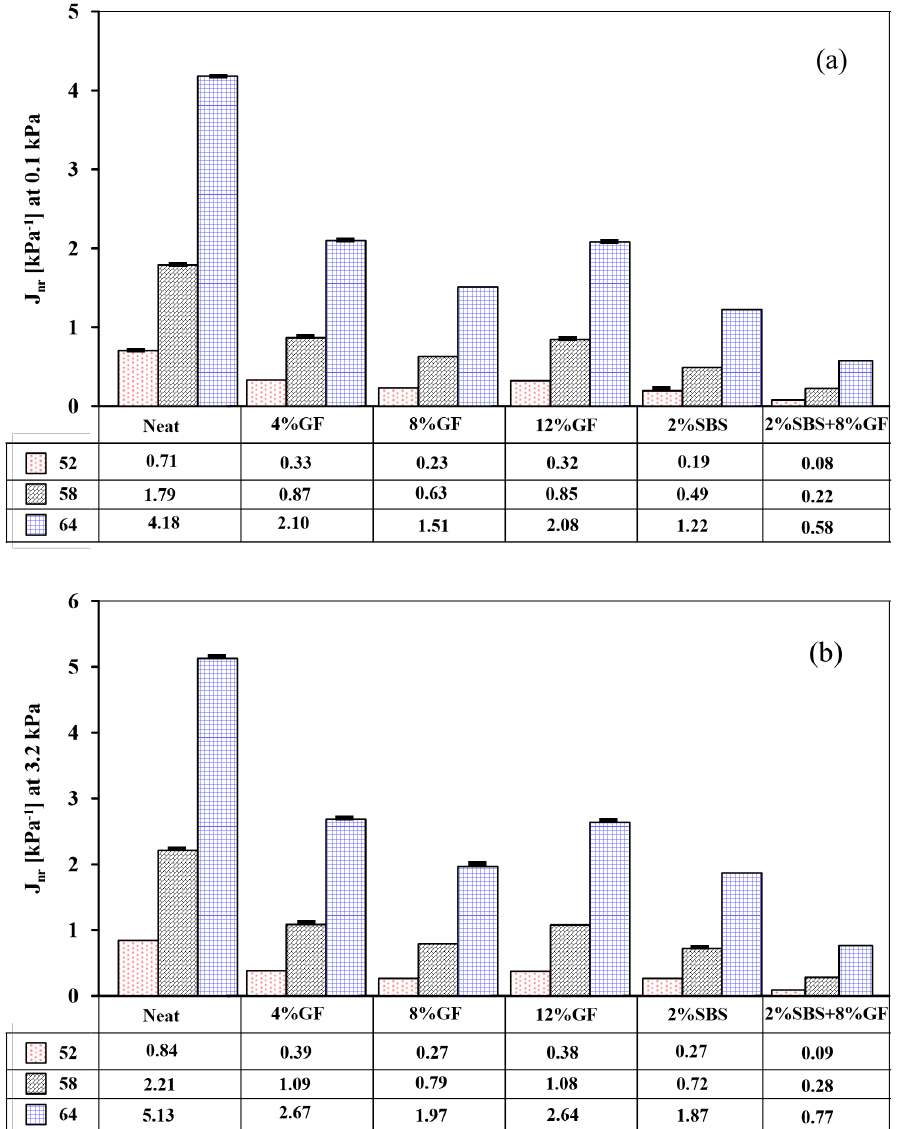
Figure 9. Non-recoverable creep compliance of neat and modified asphalt binders at ( a ) 0.1 kPa and ( b ) 3.2